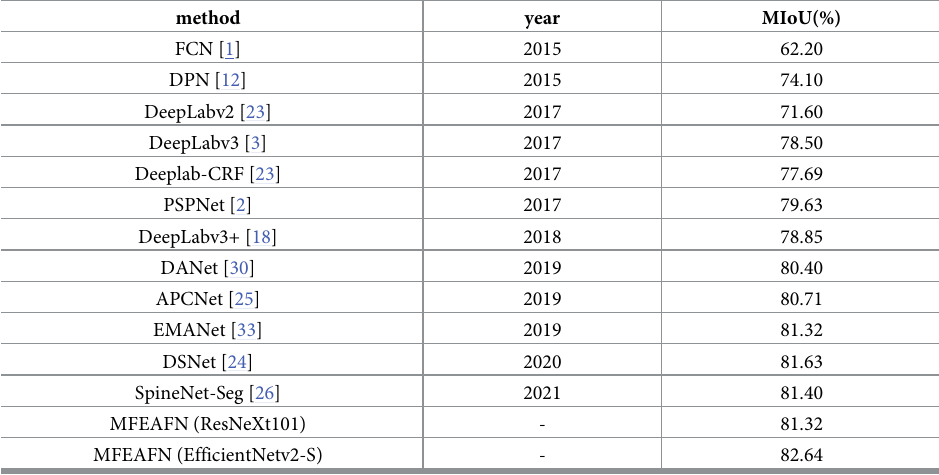
Table 4. Comparison with state-of-the-art Meth on PASCAL VOC 2012